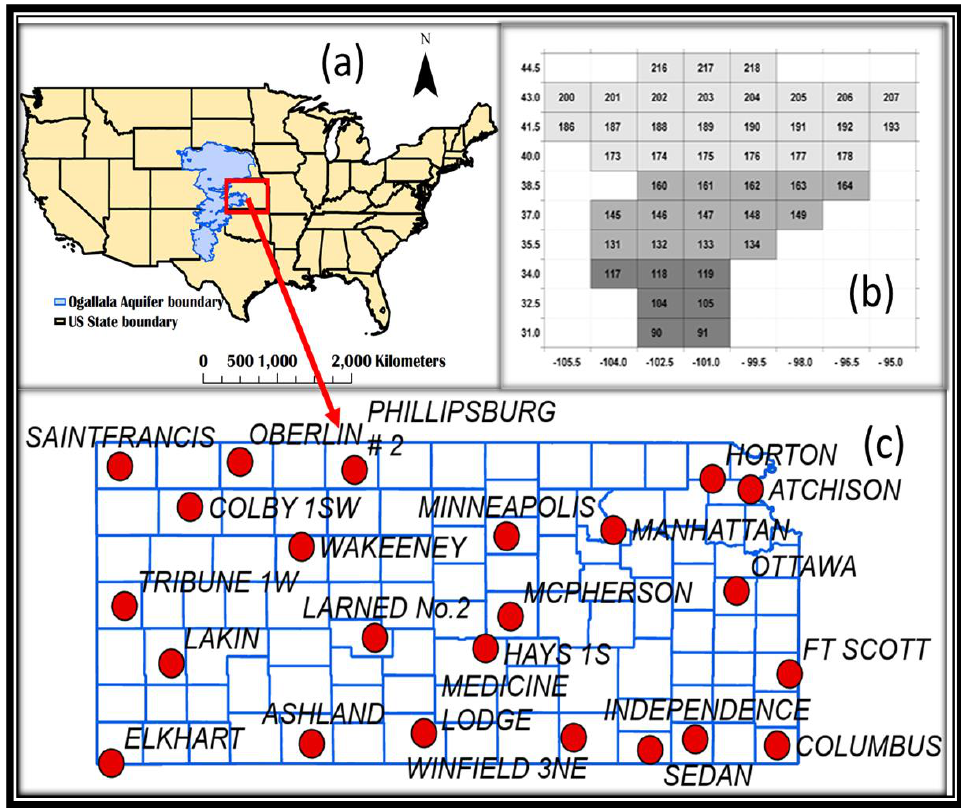
Figure 1. Study domain: ( a ) for objective 1 — Ogallala Aquifer region; ( b ) the grids used to extract the data for objective 1 and; ( c ) the Kansas stations selected for the analysis of objective 2. The thick red box represents the domain (Kansas state) for objective 2.